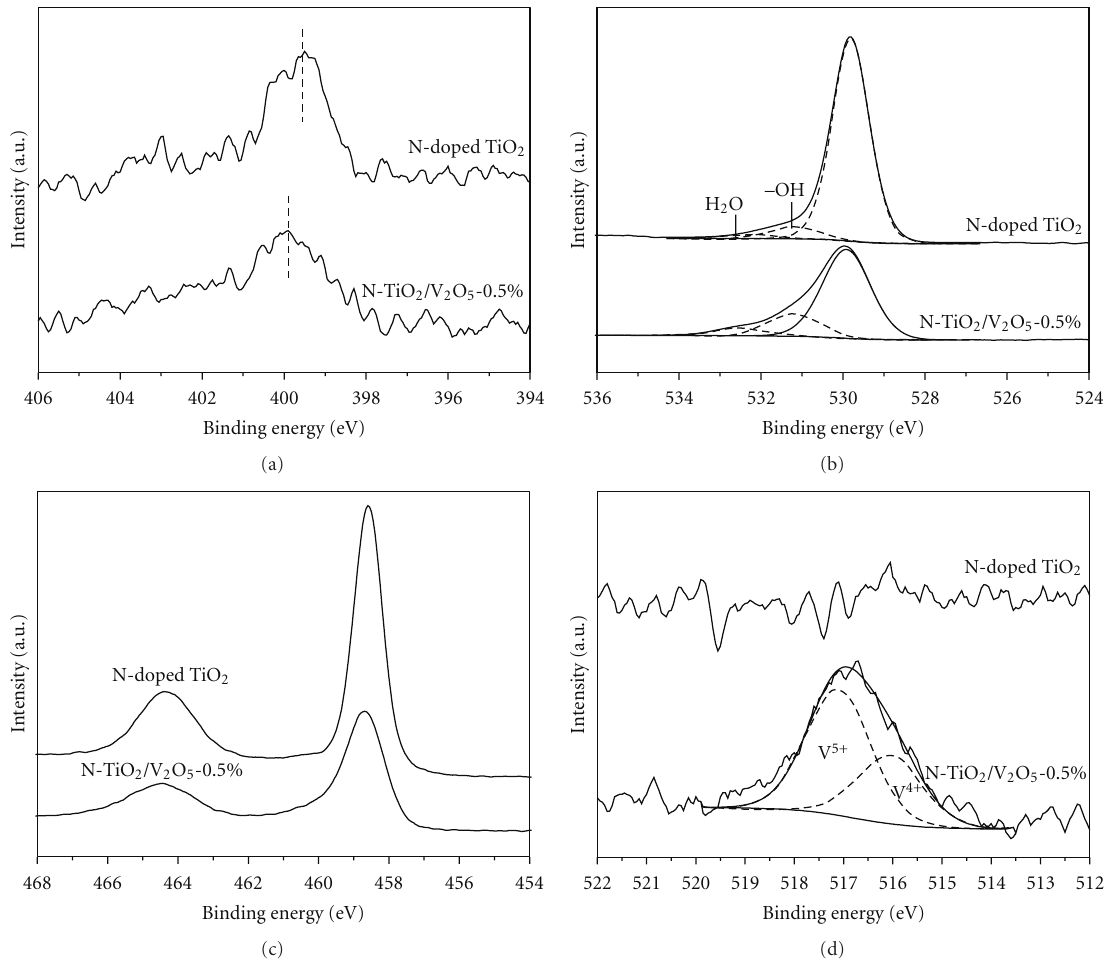
Figure 4: XPS spectra for N-doped TiO 2 and N-TiO 2 /V 2 O 5 -0.5% samples of N1s (a), O1s (b), Ti2p, (c) and V2p (d).